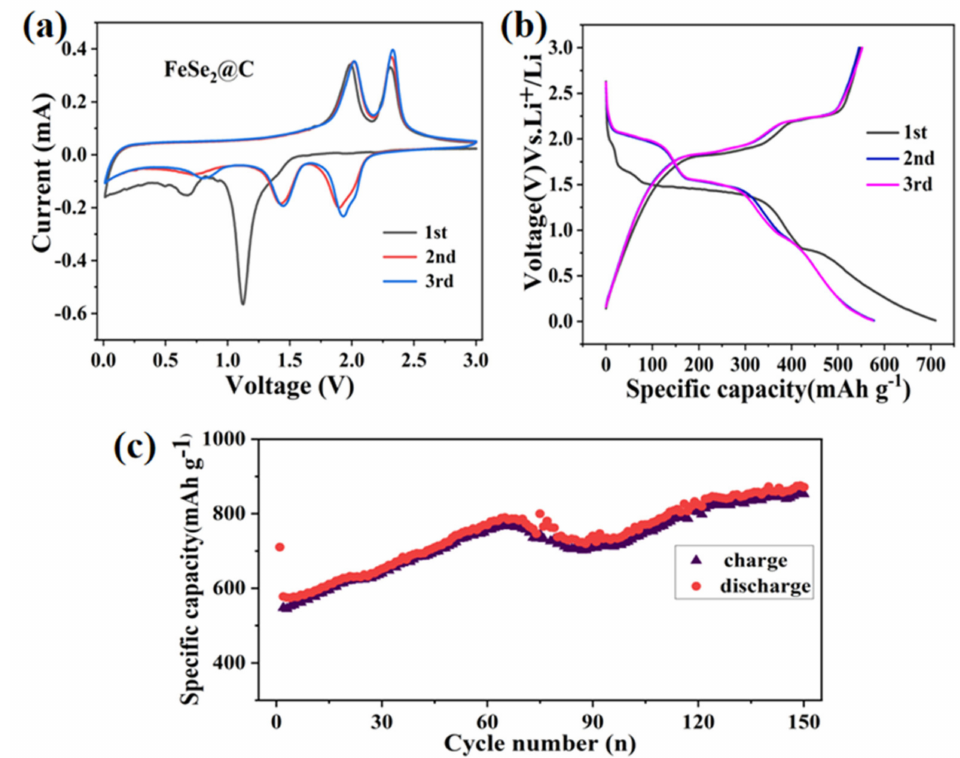
Figure 9. Electrochemical properties of the FeSe 2 @C electrode: ( a ) Cyclic voltammograms between 0.01 and 3 V at a potential sweep rate of 0.1 mV s − 1 . ( b ) Discharge/charge profiles at 0.1 A g − 1 , ( c ) Cycling performance at 0.1 A g − 1